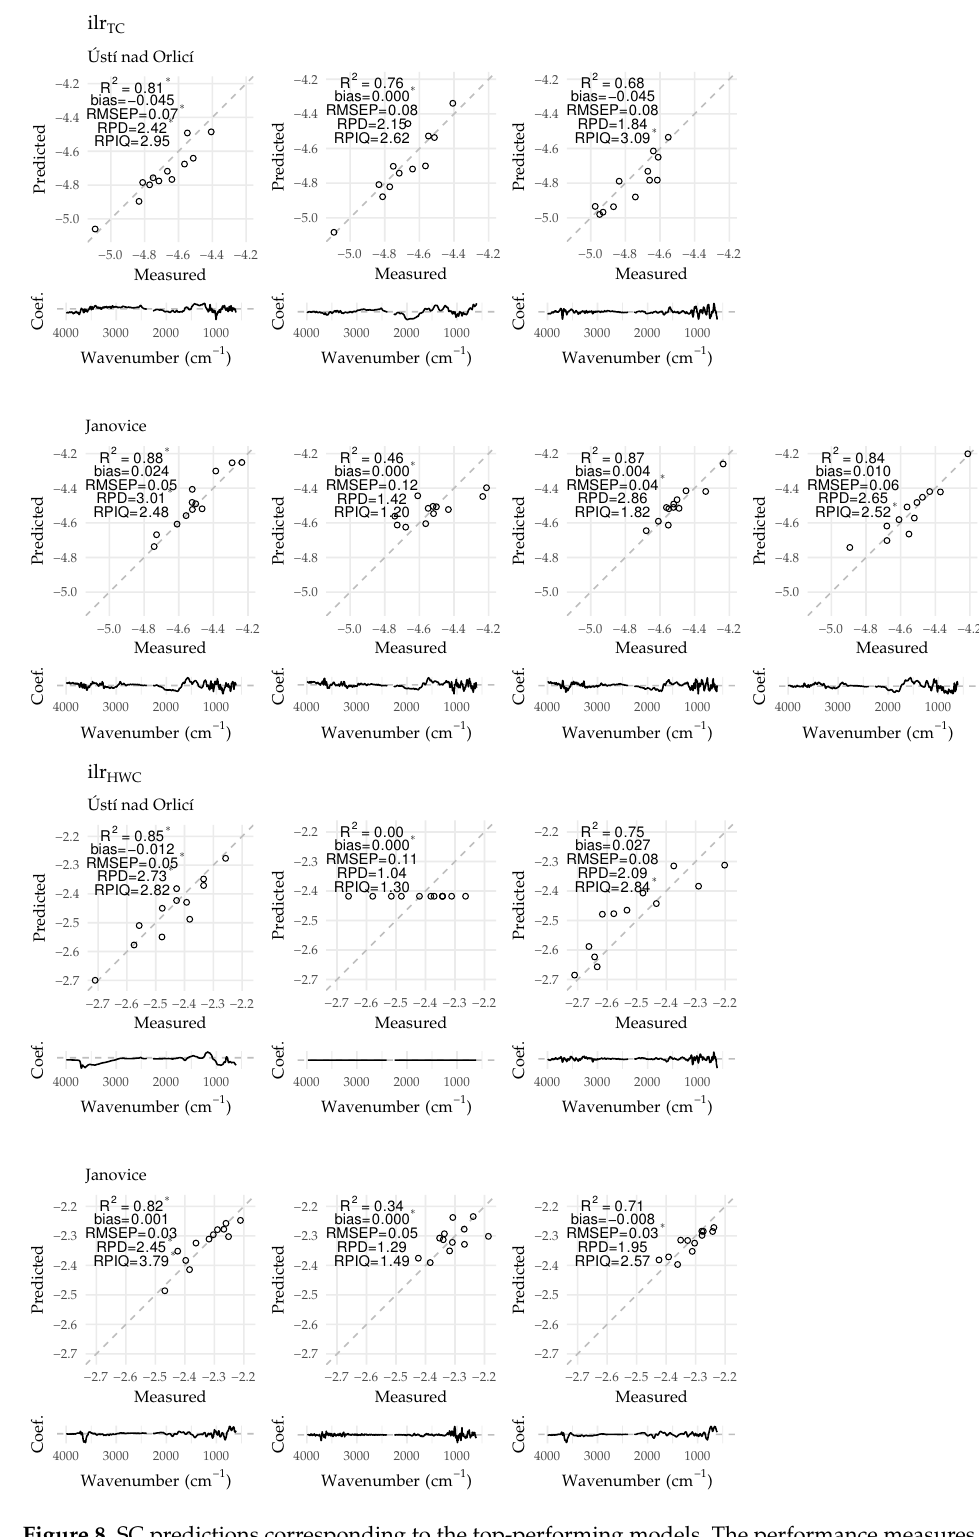
Figure 8. SC predictions corresponding to the top-performing models. The performance measures ac- cording to which individual formulations performed best are marked with asterisks. PLSR regression coefficients are shown for each model on a relative scale due to the coefficient ranges differing by orders of magnitude between the